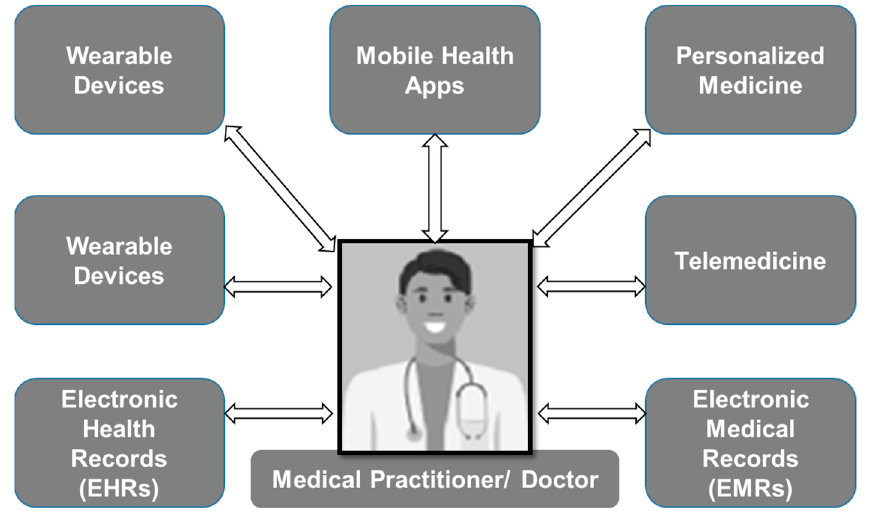
Figure 1. Digital Health Technologies .